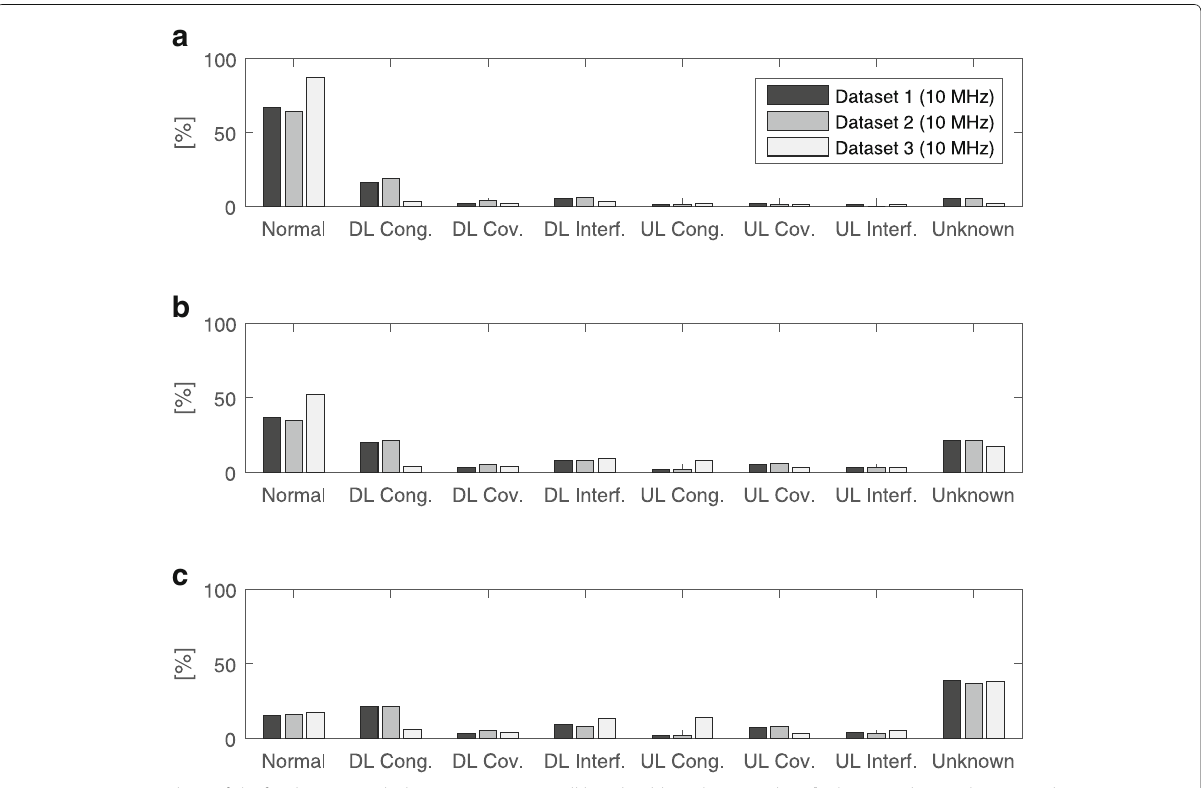
Fig. 4 Sensitivity analysis of th 1 for datasets with the same (10 MHz) cell bandwidth. a th 1 = 2 Mbps. b th 1 = 5 Mbps. c th 1 = 10